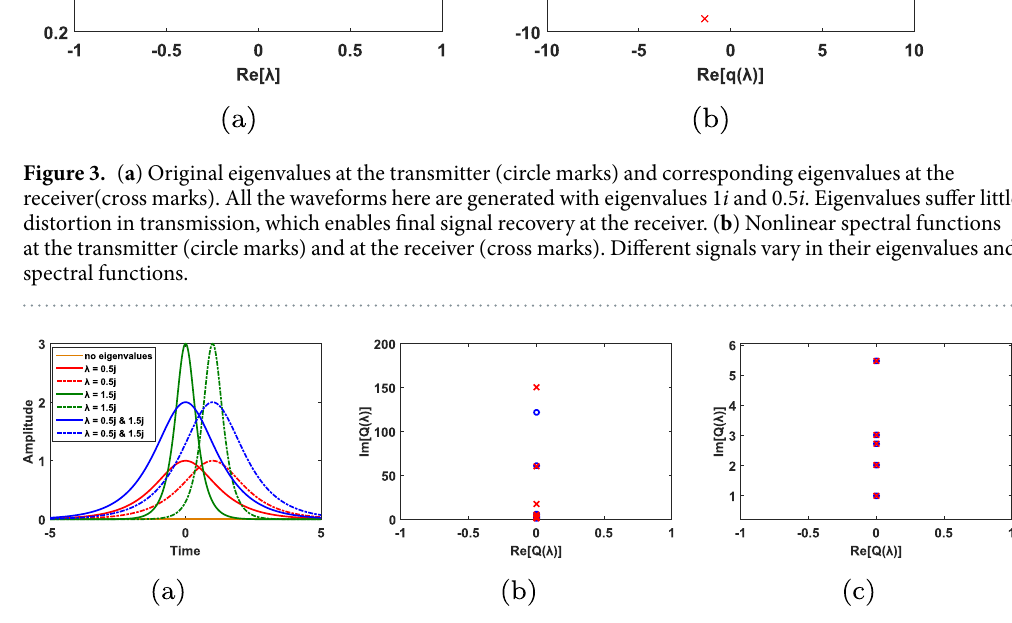
Figure 4. ( a ) Transmitted signals produced by INFT and time shift. ( b ) Nonlinear spectral functions at the transmitter (circle marks) and at the receiver (cross marks). Different signals vary in their spectral amplitudes. ( c ) Enlarged view of ( b ). Lower spectral amplitudes suffer less distortion in nonlinear frequency